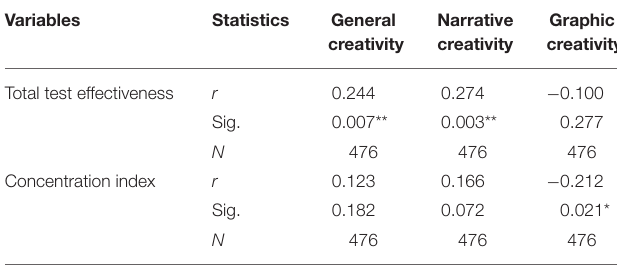
TABLE 3 | Correlations between creativity and